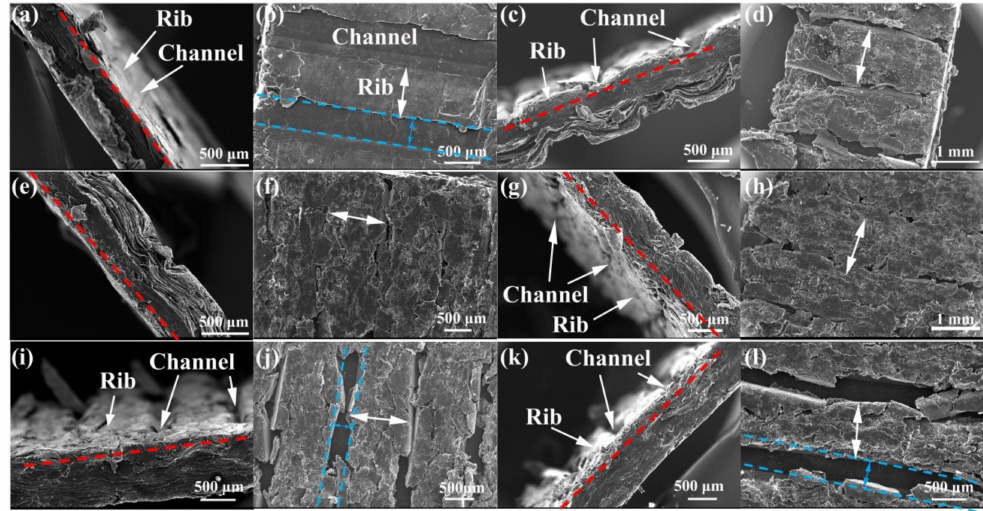
Figure 9. Compressive failure morphology of composite BPs. Cross-section morphology of ( a ) HU-BP, ( c ) HL-BP, ( e ) HM-BP, ( g ) HH-BP, ( i ) MH-BP, and ( k ) LH-BP; the corresponding in-plane surface morphology of ( b ) HU-BP, ( d ) HL-BP, ( f ) HM-BP, ( h ) HH-BP, ( j ) MH-BP, and ( l )